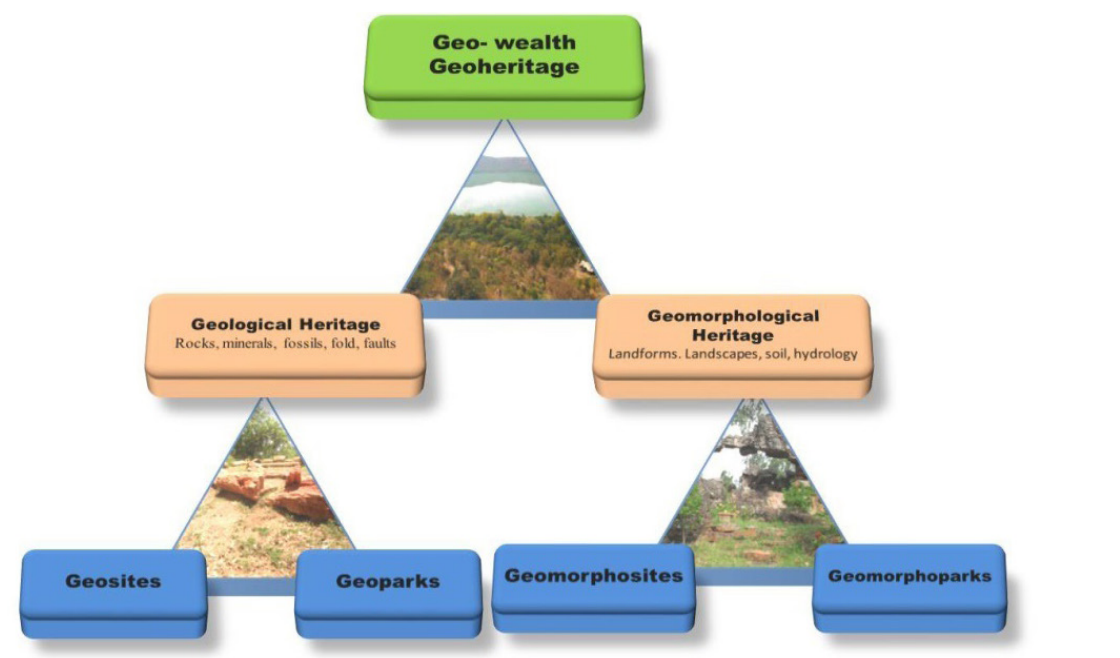
Figure 2. Simplified classification of Geoweath